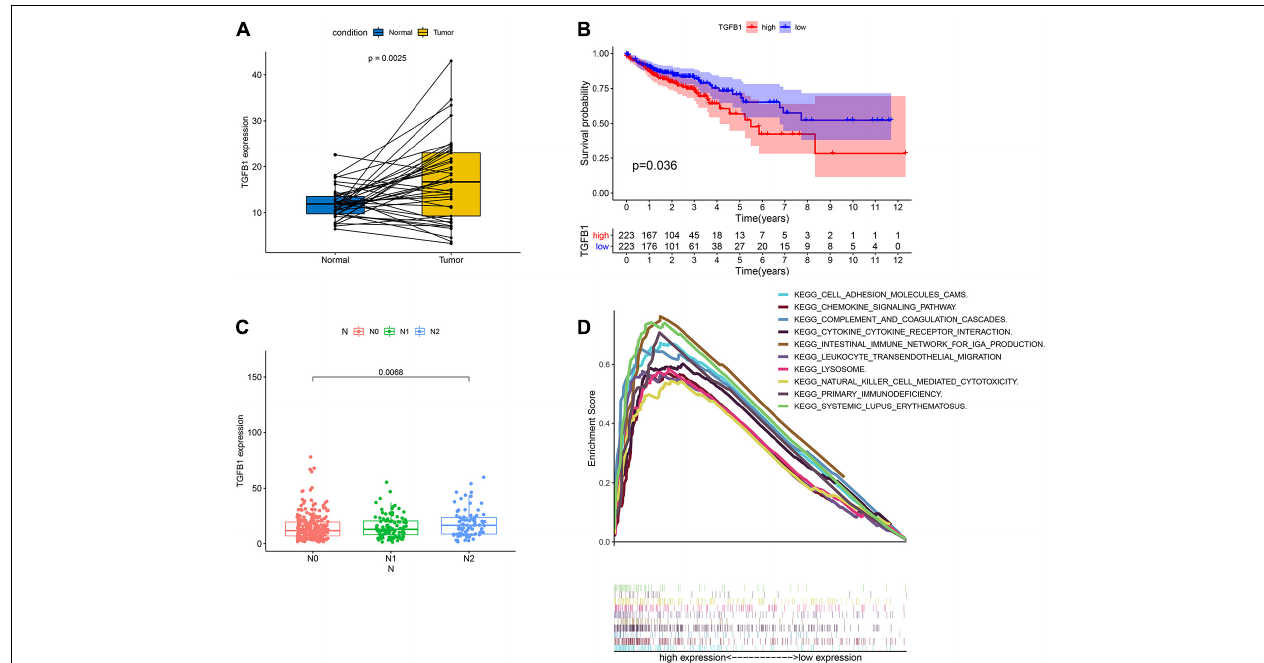
FIGURE 6 | The expression of TGF β 1 in CC patients and the association with survival, TNM classification and GSEA. (A) Paired differentiation analysis for expression of TGF β 1 in the colon cancer samples and the paired normal samples deriving from the same patient ( p = 0.0025 by Wilcoxon rank sum test). (B) Survival analysis for colon cancer patients with high expression or low expression of TGF β 1. p = 0.036 by log-rank test. (C) Association of the expression of TGF β 1 with N stage by Kruskal–Wallis rank sum test; p = 0.0068. (D) GSEA for tumor samples with high expression or low expression of TGF β 1.